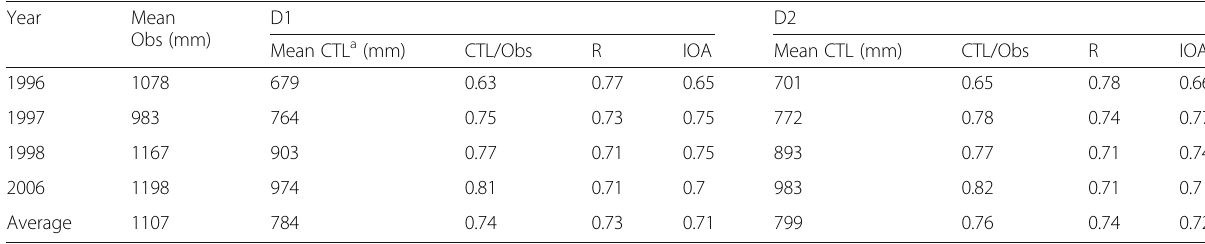
Table 4 Statistical measures for WRF simulated rainfall over JJA